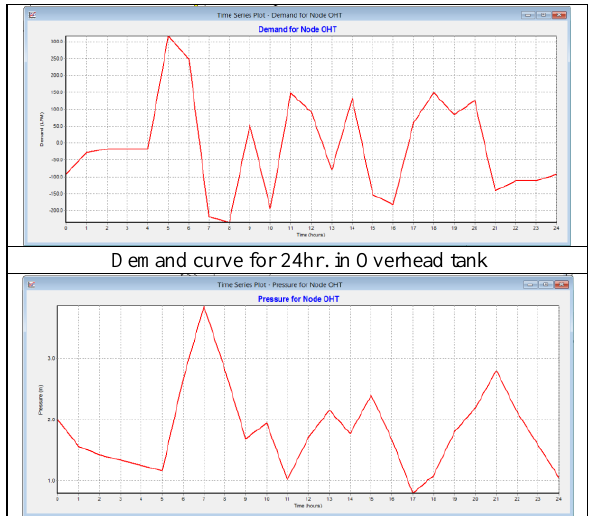
Figure 7 Curves generated by EPANET 2.0